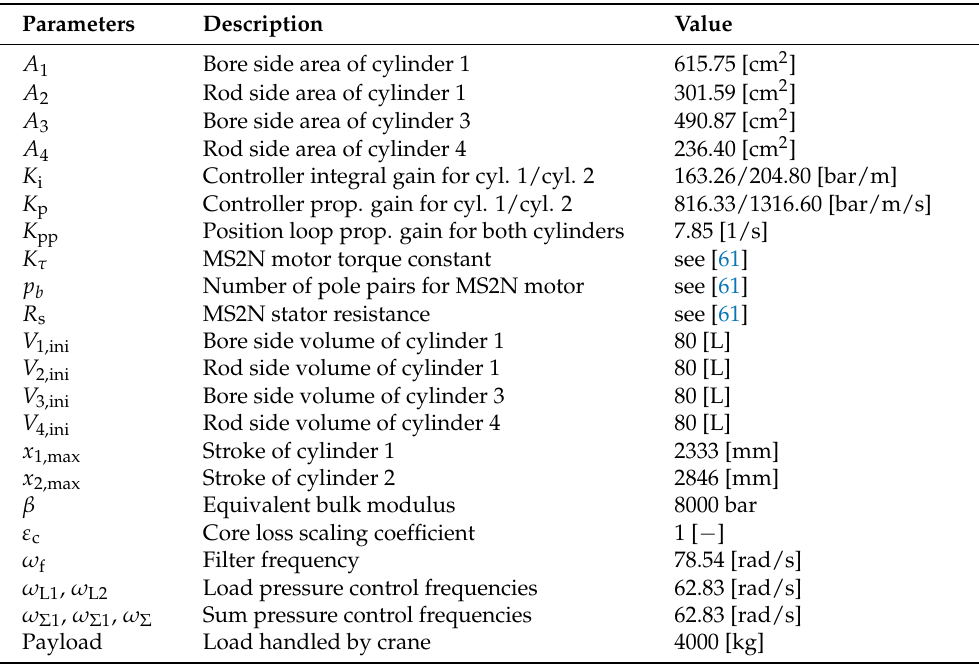
Table A1. Parameters used in the case study.